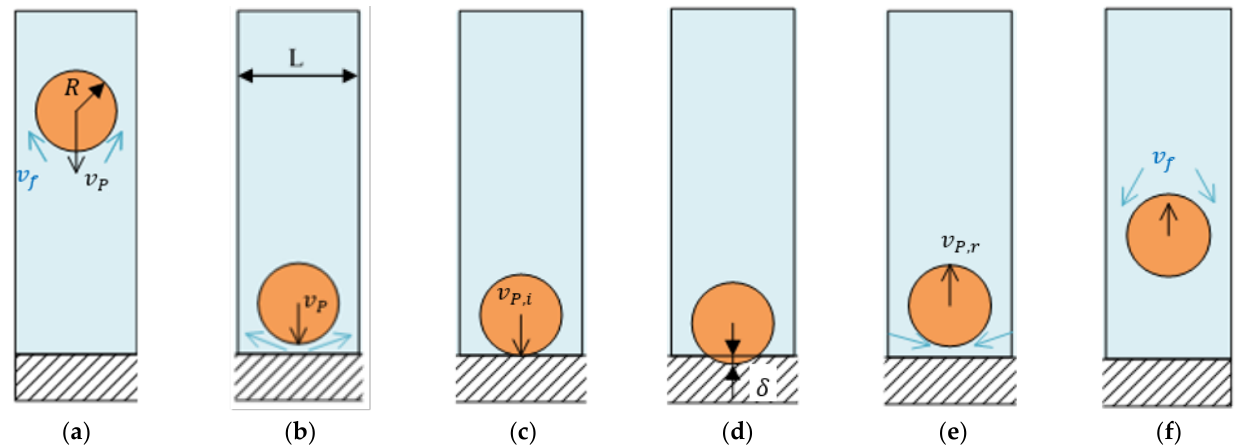
Figure 5. Particle impact on a solid surface and rebound in a closed container with liquid: ( a ) particle sedimentation down to the bottom wall and counter flow of liquid, ( b ) particle approaches the wall and squeezes liquid from the gap, ( c ) first contact with wall, ( d ) particle-wall contact deformation δ, ( e ) rebound of particle, fluid streams back into gap, ( f ) rebound of particle, counter flow of fluid.